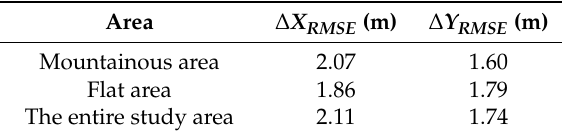
Table 2. Final accuracies of the assembled DISP image map in the study